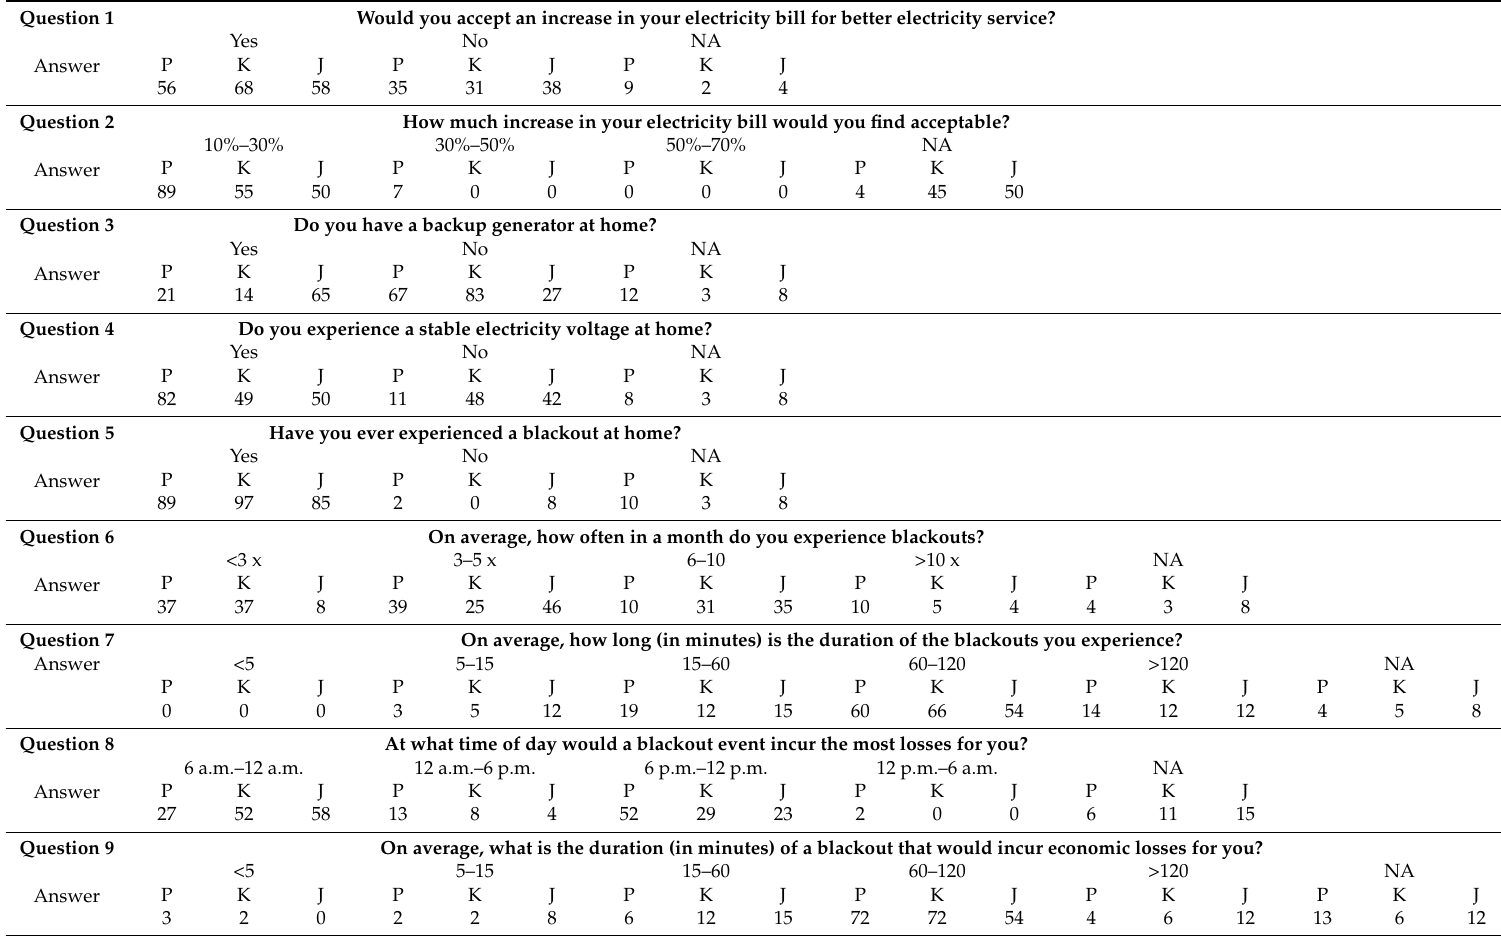
Table A2. The proportion of respondents’ answers to survey questions, in